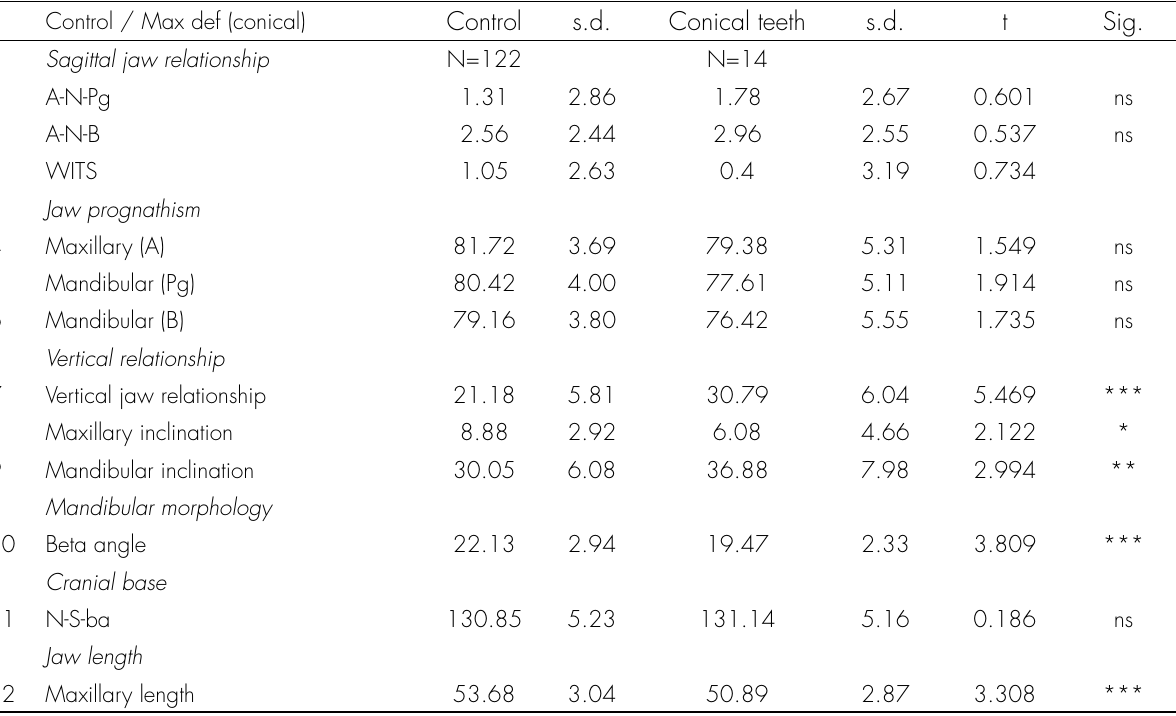
Table IIIb. Comparison between groups of the experimental material and the control material in terms of conical anomaly of maxillary